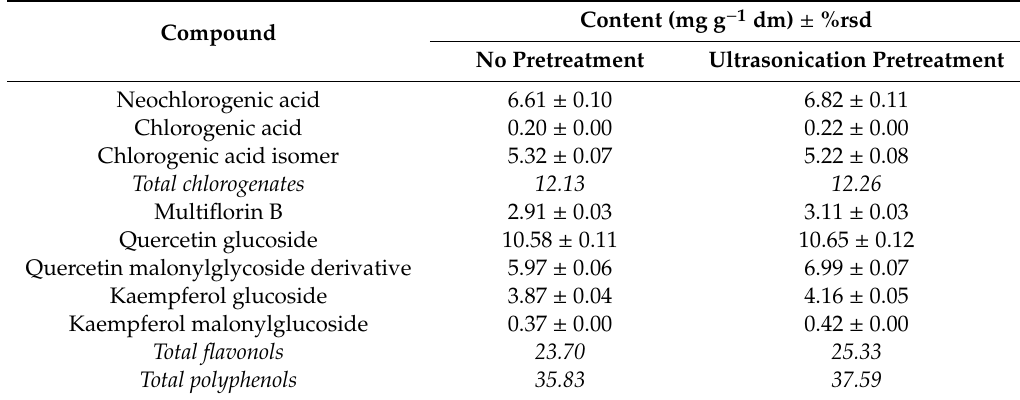
Table 8. Quantitative data for the major polyphenols detected in M. oleifera